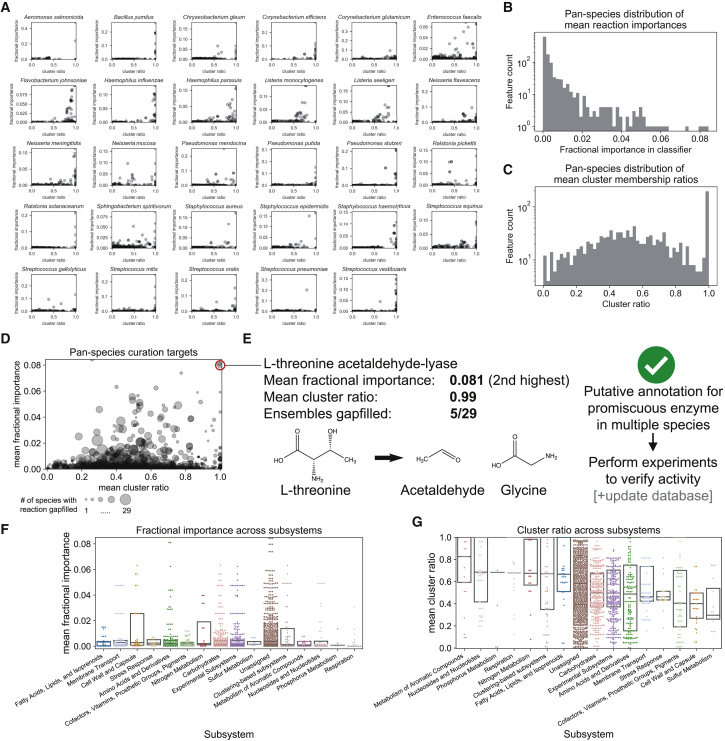
Analysis of AMMEDEUS Curation Targets for 29 Bacterial Species(A) Curation target plots for all 29 species generated with AMMEDEUS.(B) Distribution of mean fractional importances across all species. For each gap-filled reaction, fractional importances were averaged across all ensembles in which the reaction was gap filled; the histogram of these means is shown.(C) Distribution of mean cluster ratios across all species. Data handled the same as in (B).(D) Compiled curation target plot for all species. Size of each point represents the number of species for which the reaction was gap filled.(E) L-threonine acetaldehyde-lyase, which had the second highest pan-species mean fractional importance. Species for which the reaction was gap filled lack an annotated L-threonine aldolase, the primary enzyme known to catalyze this reaction. However, the two species for which this reaction was in the top 10 most important reactions have an annotation for serine hydroxymethyltransferase, which promiscuously catalyzes this reaction.(F and G) Mean fractional importance (F) and cluster ratio (G) across all species by subsystem. Subsystem colors are the same in (F) and (G). Subsystems are ordered by decreasing median from left to right in both panels. Only subsystems with at least 10 gap-filled reactions are shown. Boxplots show median (center line) and extend to the 25th and 75th percentile.